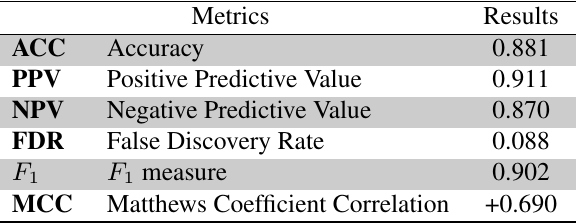
Table 3. Effect of registration errors in the estimation of V ol corr and Area corr